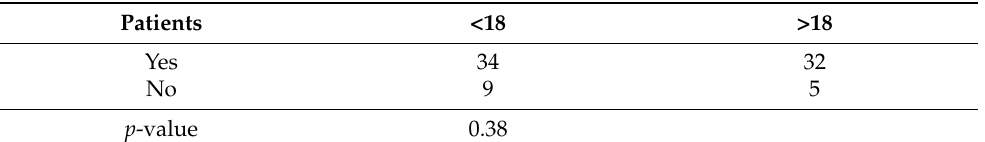
Table 4. Chi-square test examining the association between age and interest in reducing the number of in-office visits among the